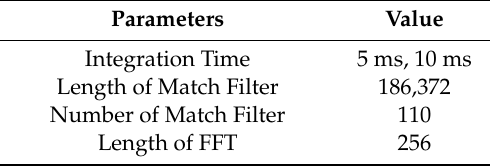
Table 3. CI-PMF-FFT acquisition parameters.